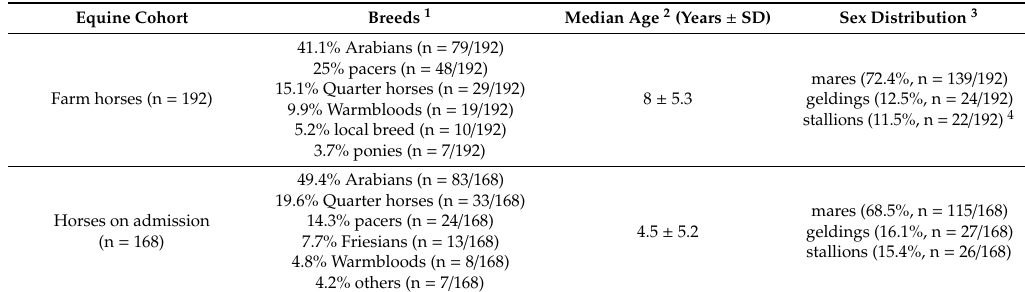
Table 1. Characterization of farm horses versus horses on admission to